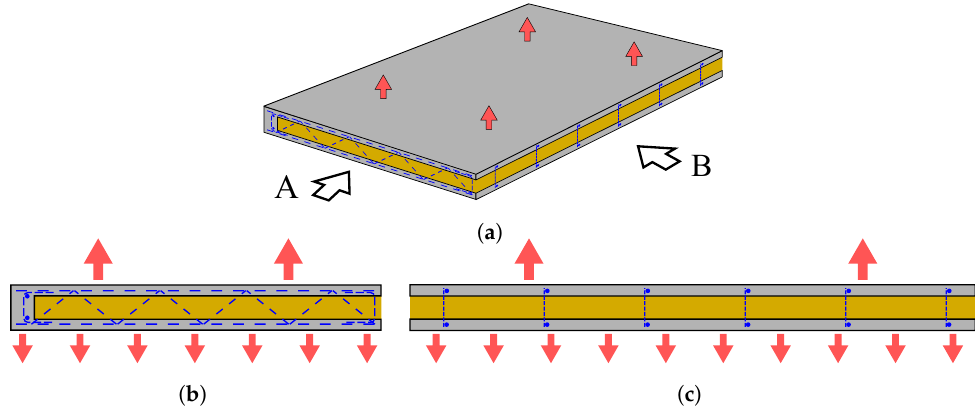
Figure 3. Load combinations in a transient design situation: ( a ) Wall in a horizontal position in isometric view. ( b ) View A and ( c ) view B of the wall. The downward arrows represent load induced due to adhesion and self-weight.